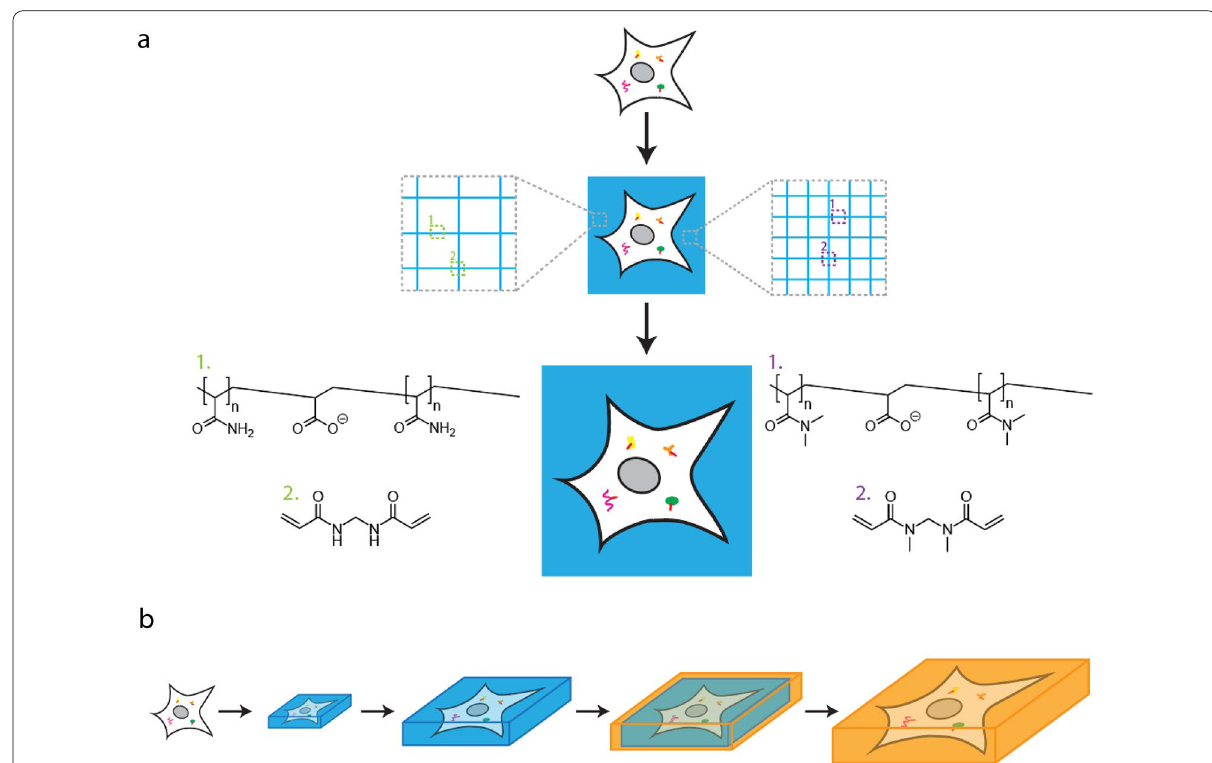
Fig. 14 ExM variants with higher expansion factors. a Single-round expansion with high expansion factor (~ 10 the hydrogel is schematically illustrated for Ten-fold Robust Expansion Microscopy (TREx, left) and X10 Expansion Microscopy (right). b Iterative expansion. First, the sample is embedded in an expanding hydrogel (blue). Next, the expanded sample-hydrogel composite is re-embedded in a second expanding hydrogel (orange) and expanded once